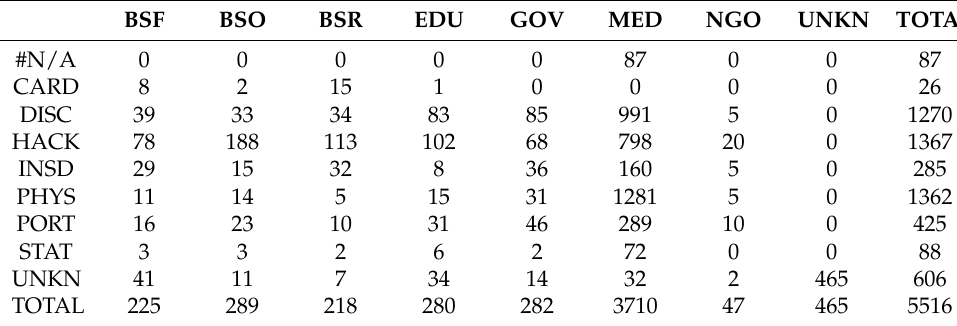
Table 3. Number of reported breaches.